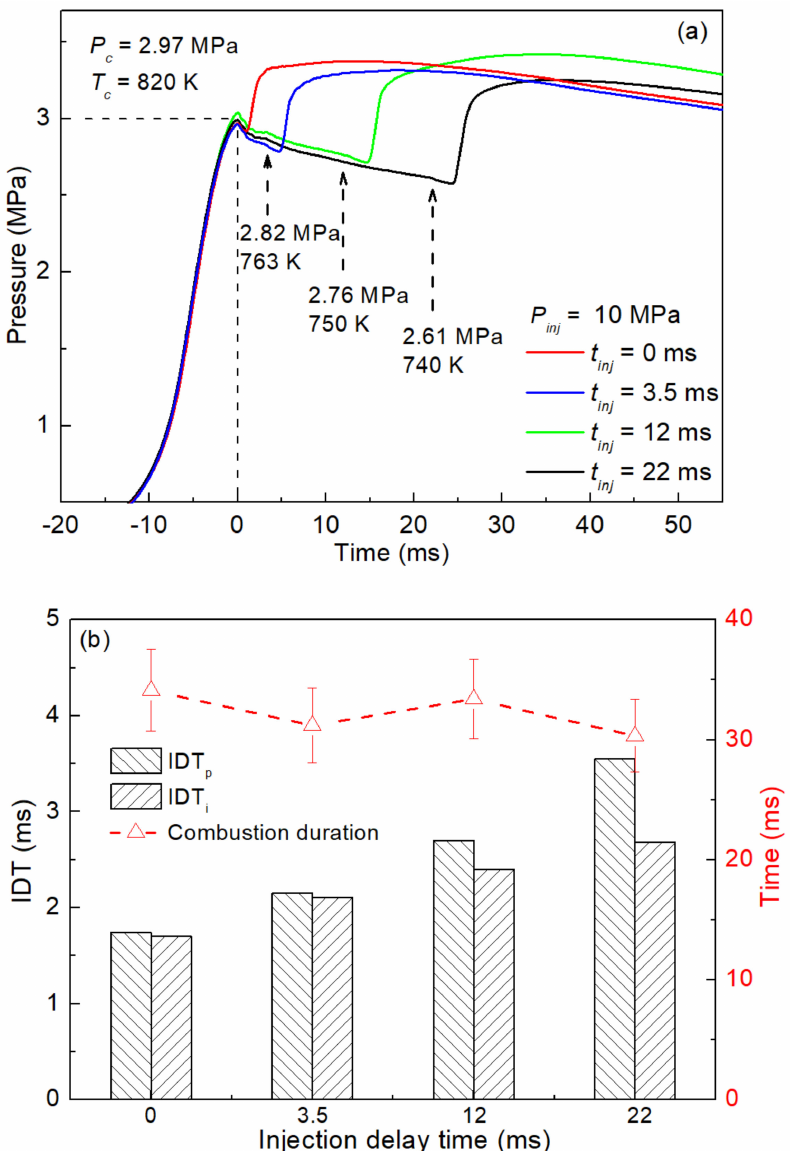
Figure 9. Effects of injection delay on pressure history ( a ), and IDT and combustion duration ( b